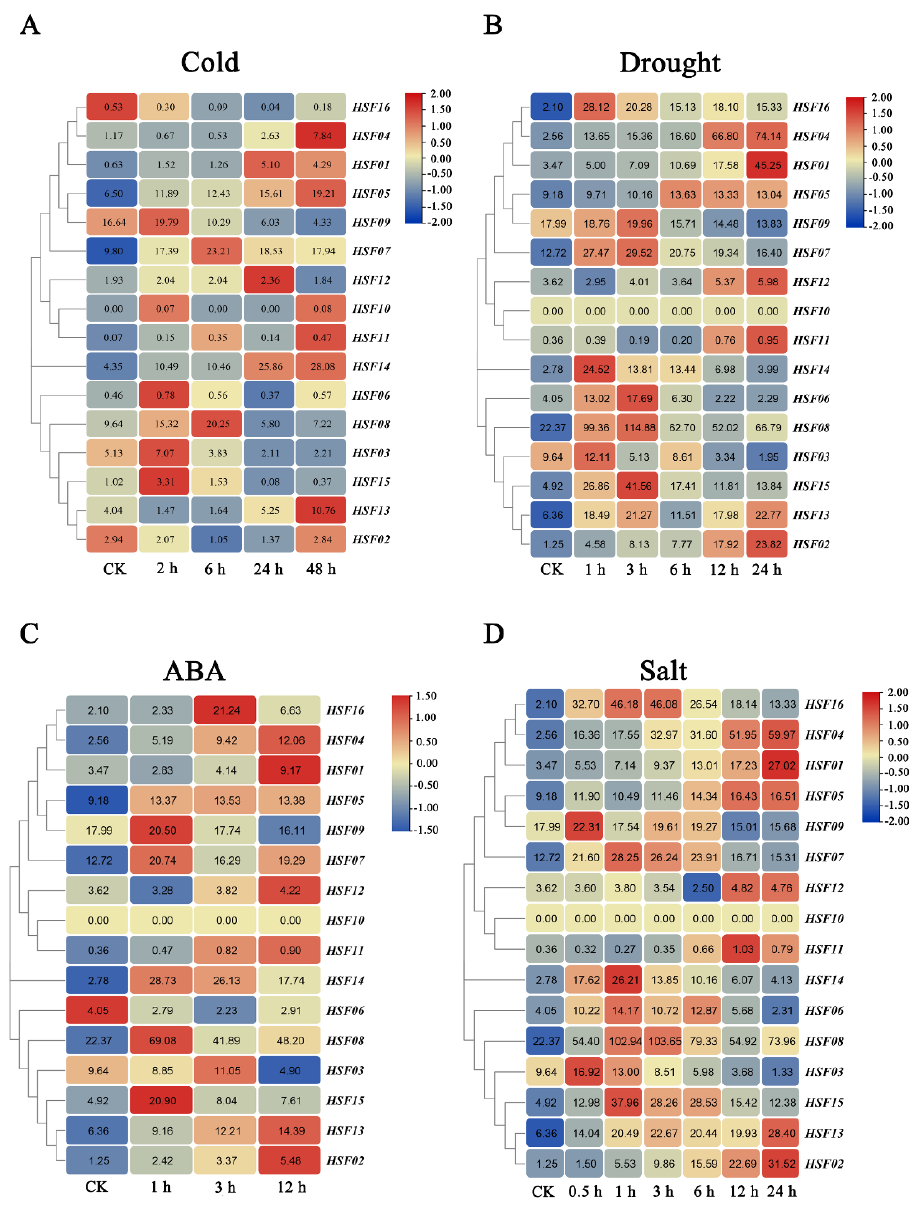
Figure 10. Expression of 16 MsHSF genes in cold ( A ), drought ( B ), ABA ( C ), and salt ( D ) treatments. The values in the rectangle represent the magnitude of the gene expression.